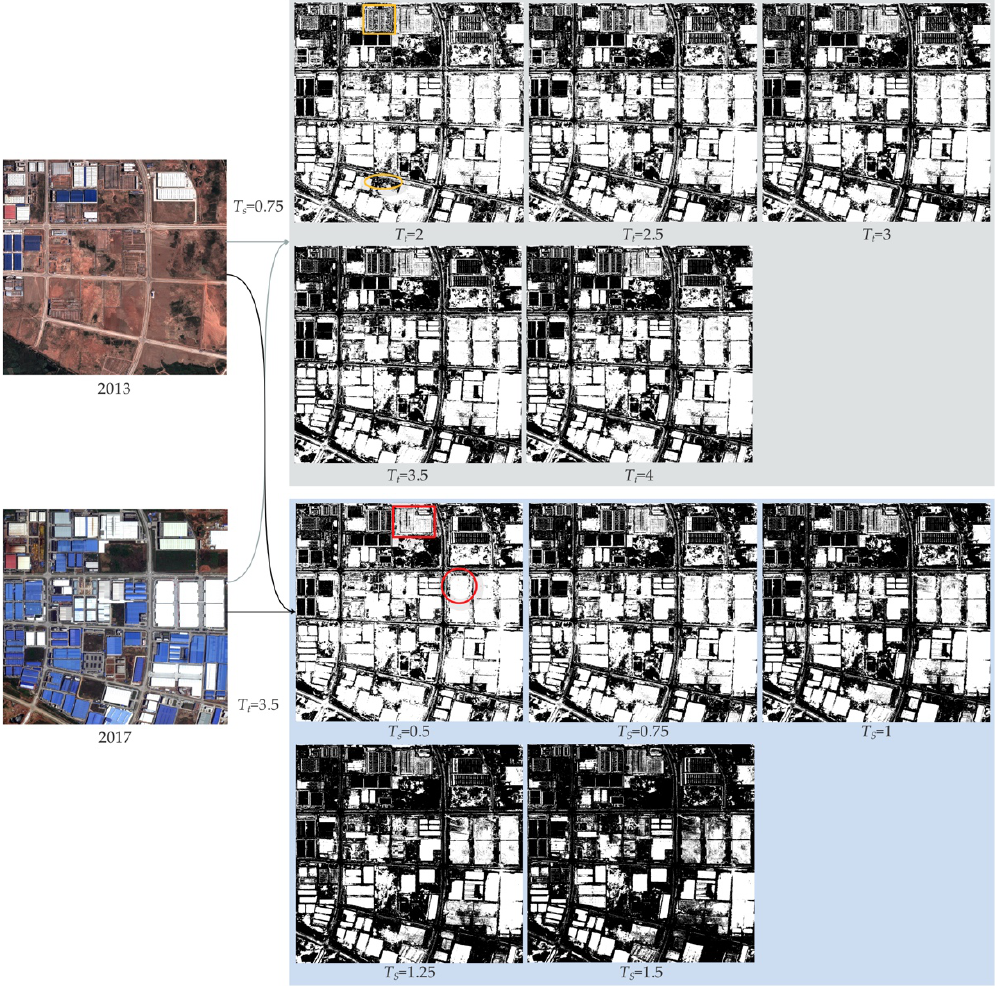
Figure 8. Differencing results with different T s and T t values.